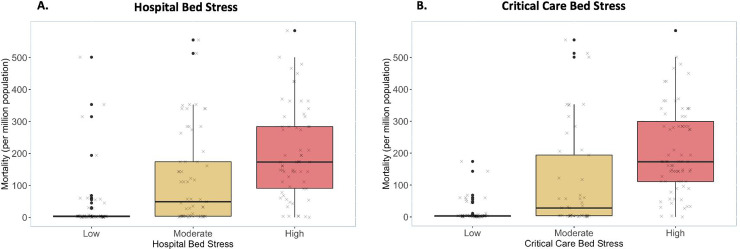
Box and whiskers plot of the relationship between national mortality rate from COVID-19 and either Hospital Bed Stress (A) or Critical Care Bed Stress (B). Black circles represent outliers and ‘x’ is a jitter plot of the raw data. p = <0.001 for all comparisons between groups.